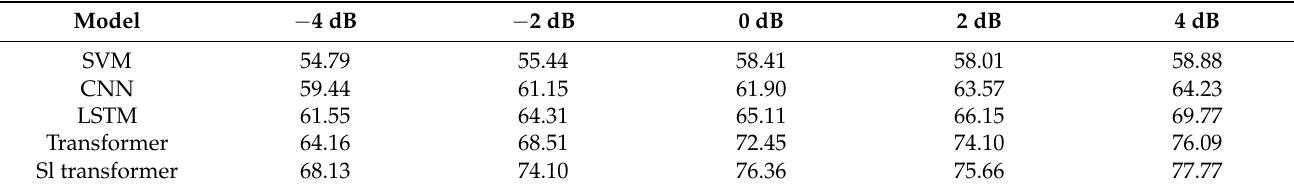
Table 4. The F1-score table of non-applying SSA algorithm for noise data.